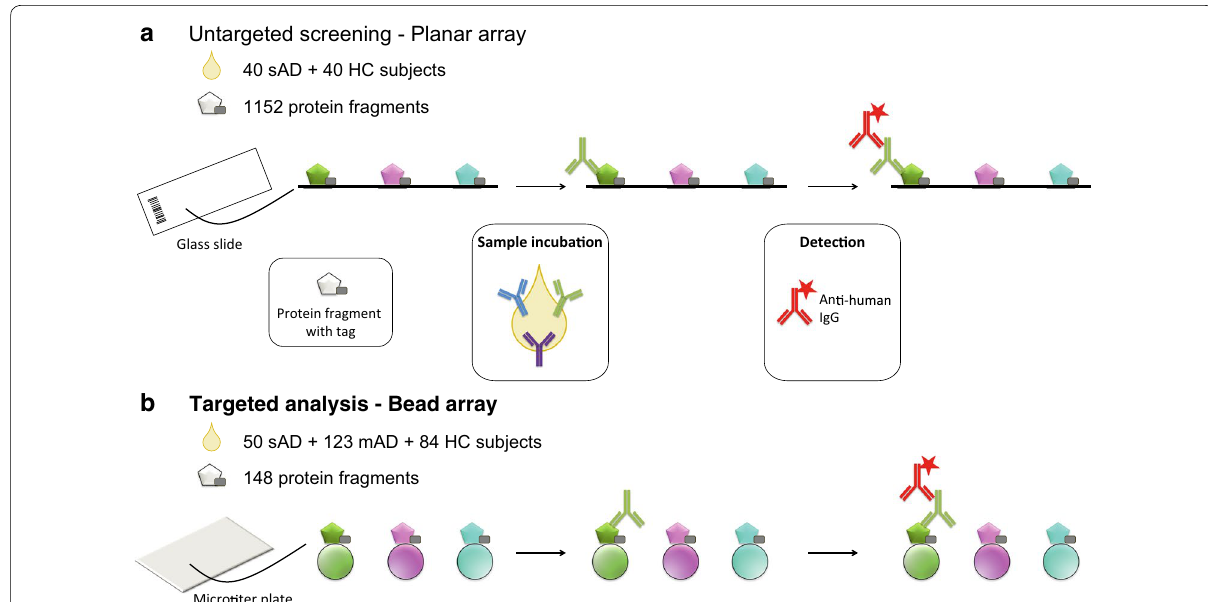
Fig. 1 Study design and method overview. a In the initial untargeted screening, a subset of 80 subjects was analyzed for IgG-reactivity towards 1152 protein fragments using planar antigen arrays. b In the targeted analysis phase, the complete cohort of 257 subjects was profiled on antigen suspension bead arrays including 148 protein fragments selected from the screening as well as from literature (see Additional file 1: Table S1). Planar and bead-based arrays included protein fragments that were either spotted on the array glass slides ( a ) or coupled to the beads ( b ). Antigens were human protein fragments expressed with an N-terminal hexa-histidine albumin binding protein (His6-ABP) tag. Arrays were incubated with plasma and autoantibodies detected using labeled anti-human IgG. HC healthy controls, AD atopic dermatitis, mAD moderate AD, sAD severe